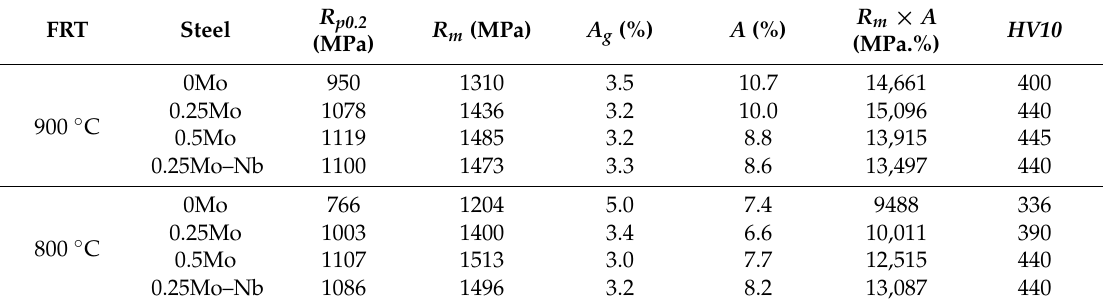
Figure 9. Correlation of the 28 J transition temperatures and the yield strength: ( a ) FRT 800 °C and ( b ) FRT 900 °C. 3.4. Correlation between Mechanical Properties and Microstructural Features